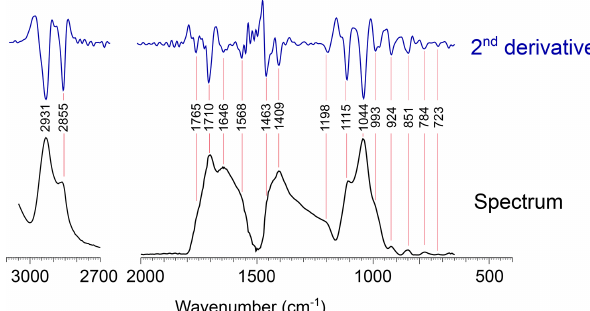
Figure 3. Detailed views of the FTIR spectrum of Thalassiphora pelagica from the Kerguelen Plateau with the second derivative. (a) Detail of the 3500–2500cm − 1 region of the FTIR absorption spectrum (transmission mode) of T. pelagica . (b) Detail of the 2000–700cm − 1 region with the maxima of the spectrum second derivative showing the locations of absorption